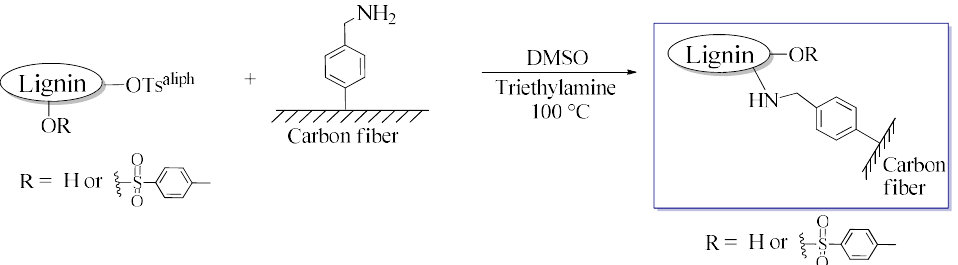
Figure 4. Immobilizing lignin derivative on the carbon fiber surface. Abbreviations: –OTs aliph —tosylated aliphatic hydroxyl groups; and DMSO—dimethyl sulfoxide.